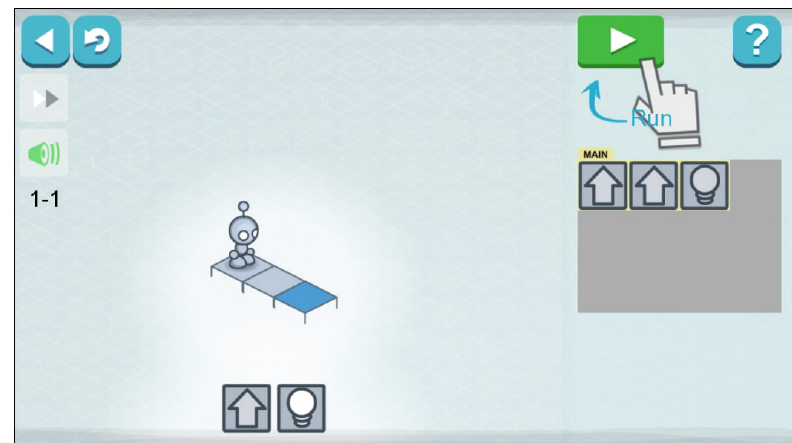
Fig. 3. Interface with the Lightbot game in action